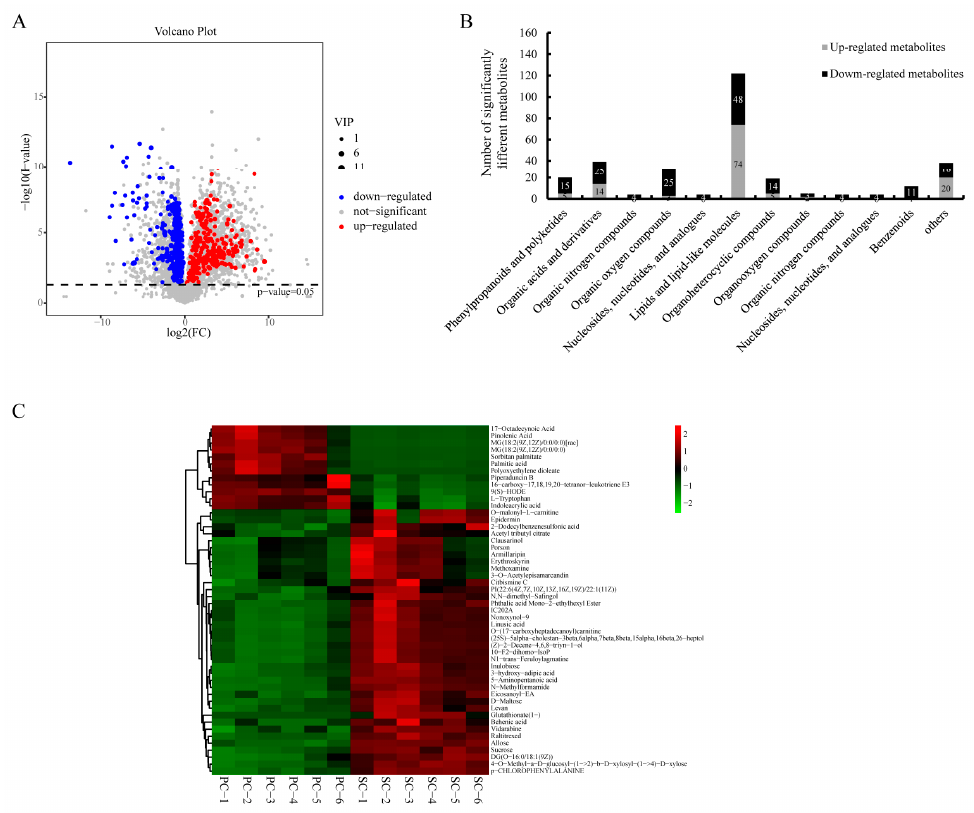
Figure 2. Significantly changed metabolites (SCMs) in PC compared to those in SC. ( A ) Volcano plot of the metabolites between SC and PC. ( B ) The number of SCMs in each category. ( C ) Heatmap of 299 SCMs. SC: M. esculenta Crantz cv. sugar cassava GPMS0991L; PC: M. esculenta Crantz cv. pink cassava BRA117315.